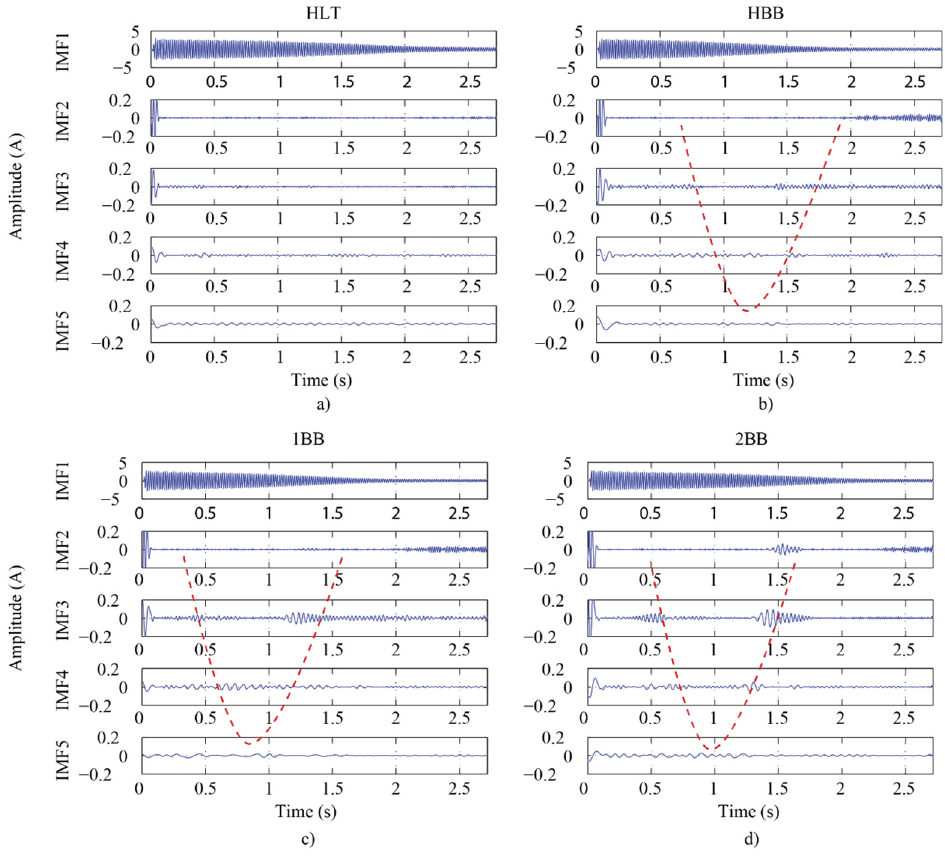
Figure 3. IMFs obtained by CEEMD technique of ( a ) HLT, ( b ) HBB, ( c ) 1BB and ( d ) 2BB conditions.